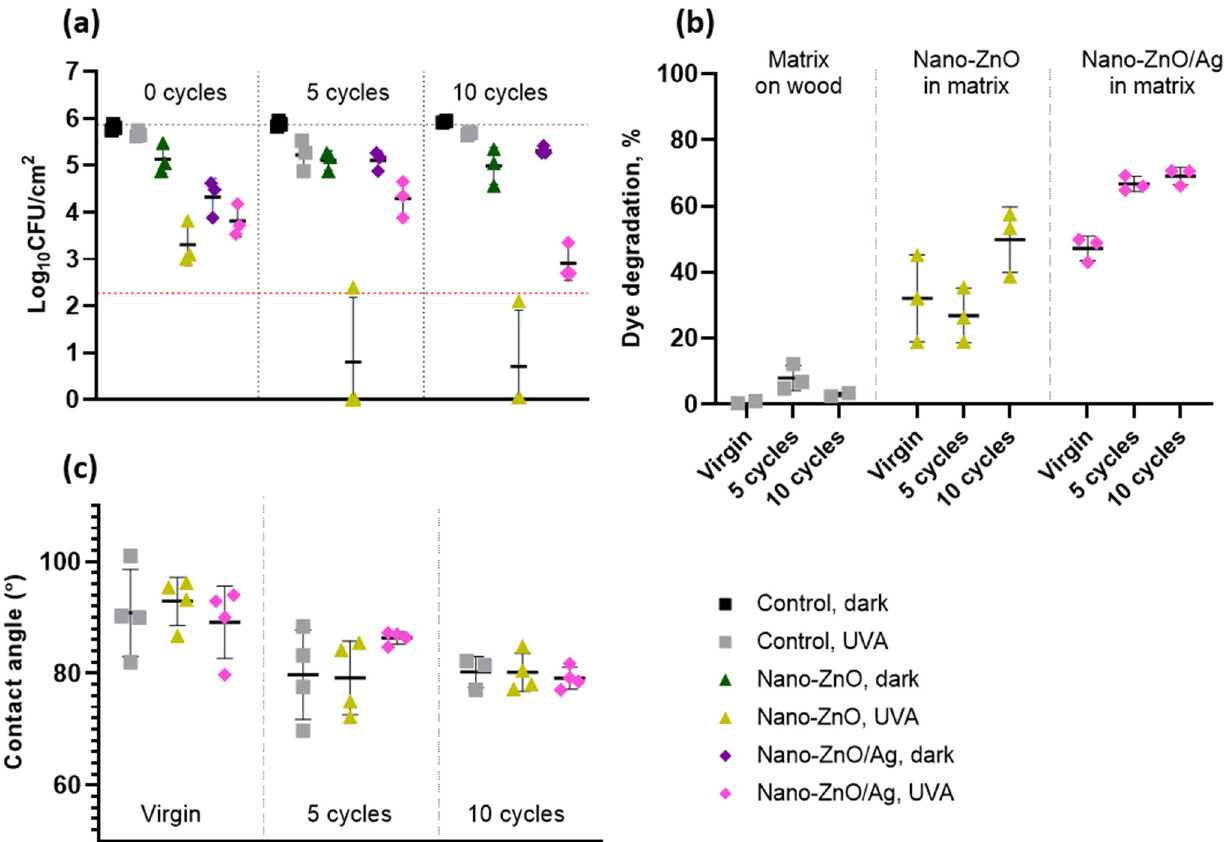
Figure 7. Effect of cyclic short-term wear on antibacterial activity towards E. coli ( a ) in the ISO test format, photocatalytic activity ( b ) and hydrophobicity ( c ) of the surfaces based on matrix-embedded nano-ZnO and nano-ZnO/Ag. Antibacterial activity of nano-ZnO/Ag surfaces in dark conditions decreased (+0.99 logs; p = 0.0056), while antibacterial activity of nano-ZnO ( − 1.0 logs; p = 0.0032) and nano-ZnO/Ag ( − 0.90 logs; p = 0.019) surfaces under UVA increased during 10 cycles of reuse compared to virgin surfaces ( a ). The latter can be explained by an increase in photocatalytic efficiency of nano- ZnO/Ag surfaces after 10 reuse cycles, with 18% ( p = 0.0125) and 22% ( p = 0.0025) increase in organic dye degradation ( b ). All the surfaces changed towards more hydrophilic surface properties, reflected in water contact angle measurements, which decreased ≥ 10% ( p < 0.05) and stabilized after 10 cycles of reuse, while the number of reuse cycles explained 47% variation between samples ( p < 0.0001) and surface type had no significant effect on hydrophilicity ( c ). Mean value of 3 experiments ± SD is presented. Red dotted line denotes the practical limit of quantification with 3 colonies counted in undiluted